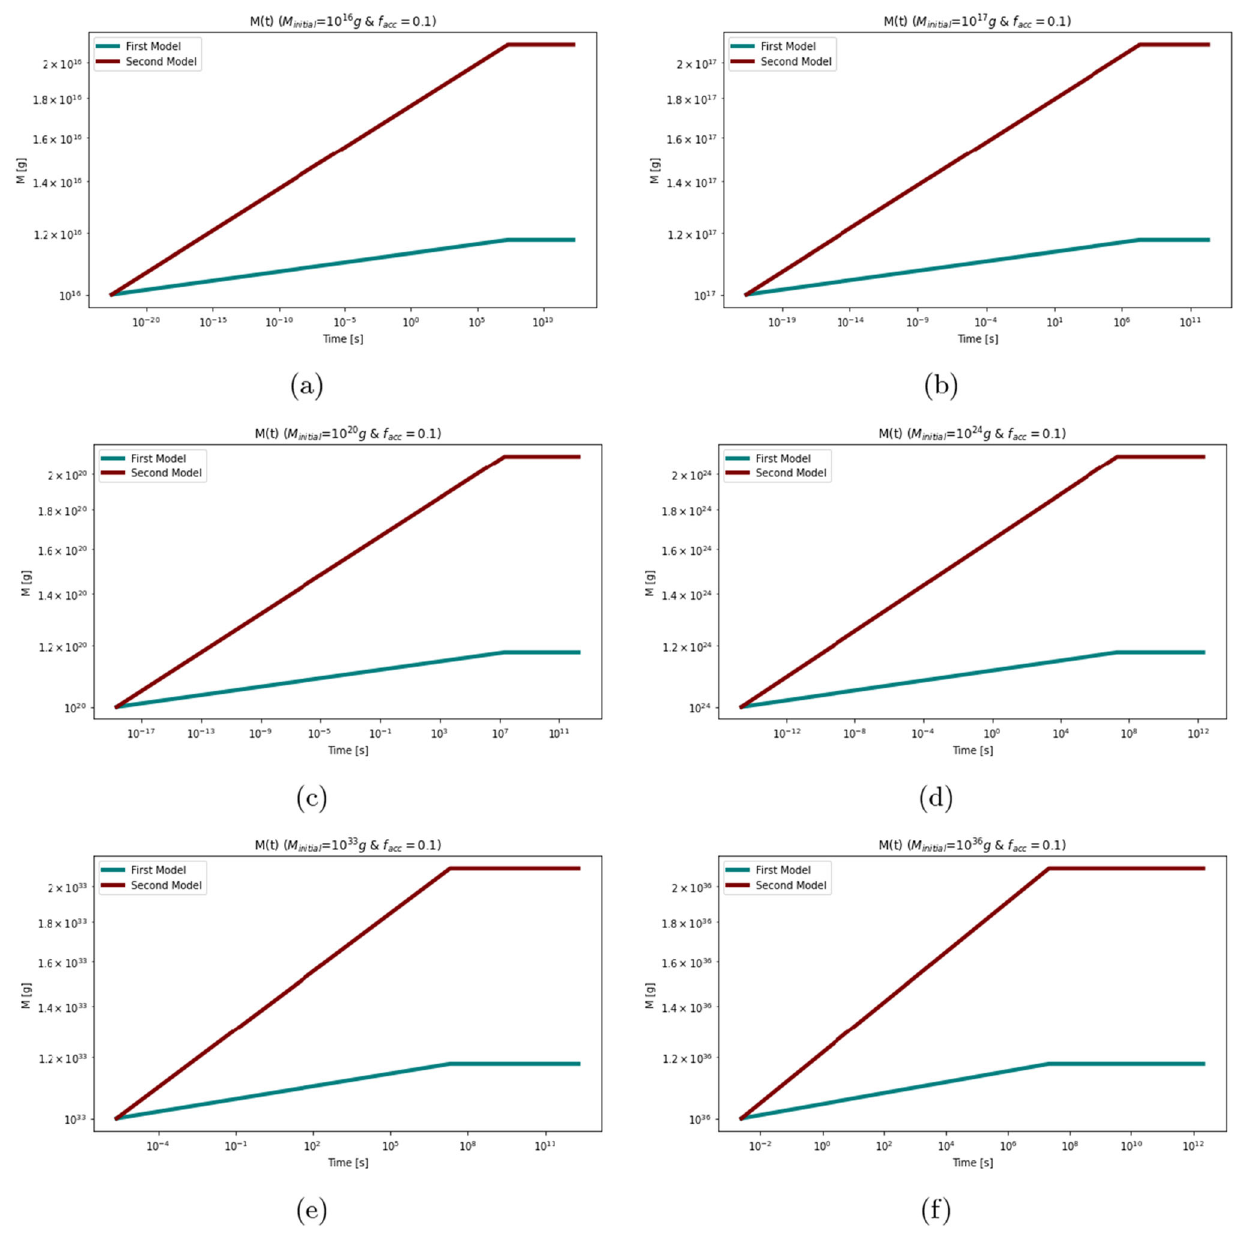
Fig. 2 This figure points out the competition accretion between two mentioned models in the radiation-dominated era for six initial masses a 10 16 g , b 10 17 g , c 10 20 g , d 10 24 g , e 10 33 g , and f 10 36 g . The second